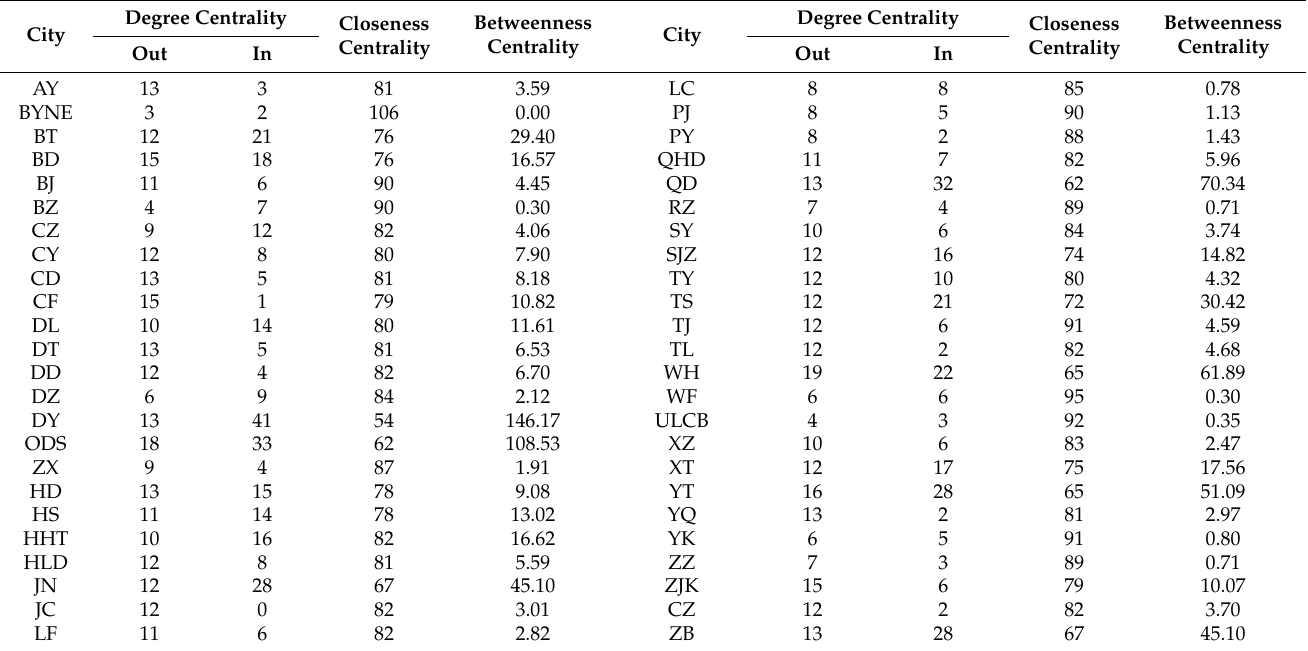
Table 4. Centrality analysis on